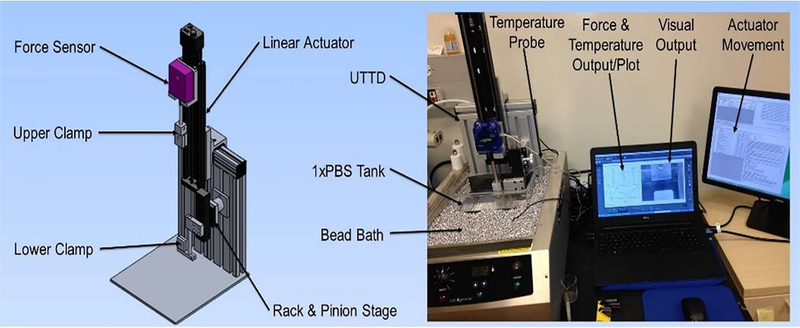
Left Uniaxial Testing Device (UTTD). Right, Assembled device and graphic user interface.